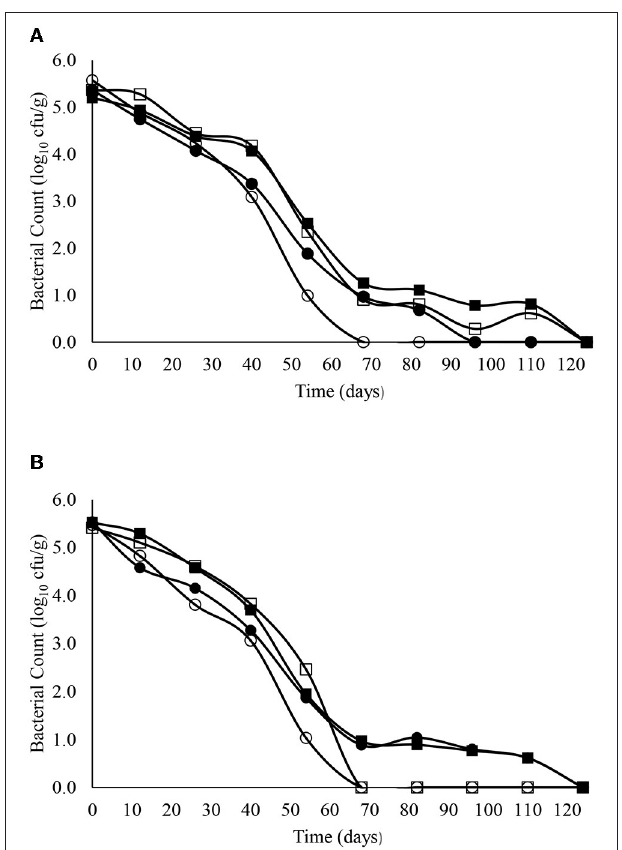
FIGURE 3 | The reduction in S. Senftenberg over time in sandy (A) and clay (B) soils including with slurry at 4 ◦ C ( (cid:4) ), digestate at 4 ◦ C ( (cid:3) ), slurry at 14 ◦ C ( • ) and digestate at 14 ◦ C